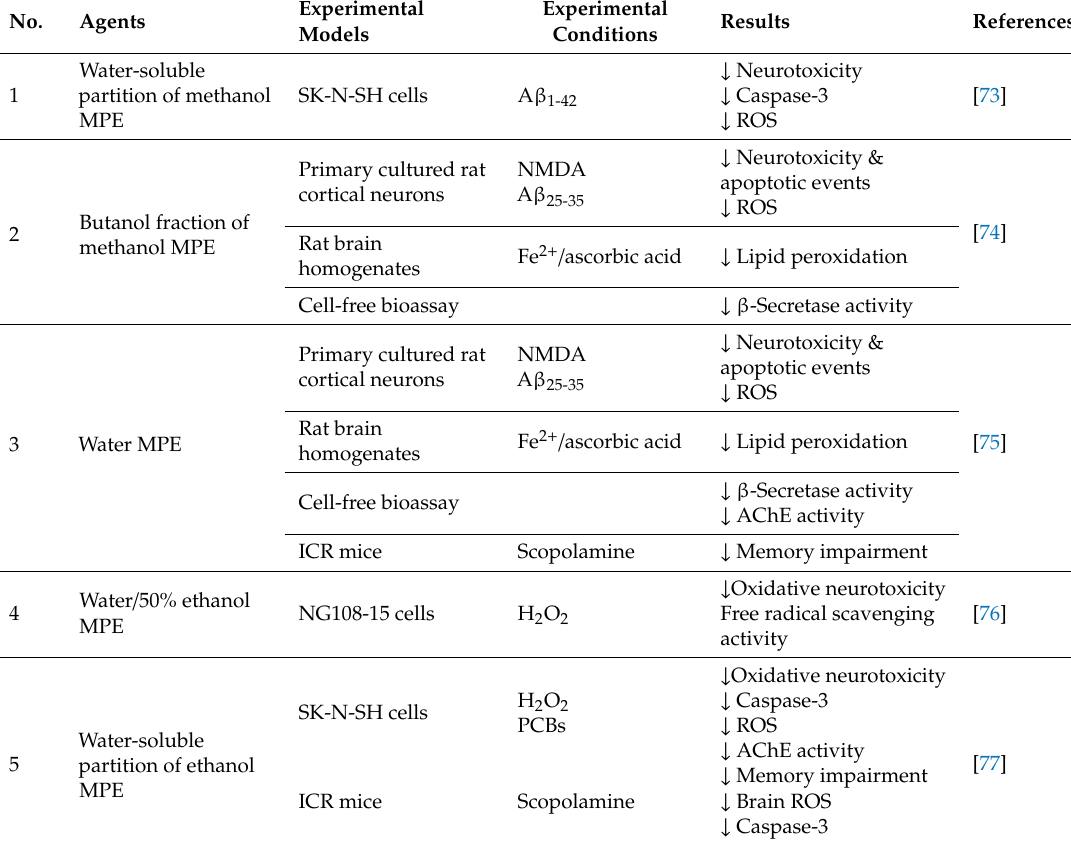
Table 1. Pharmacological e ff ects of MP-derived agents in Alzheimer’s disease